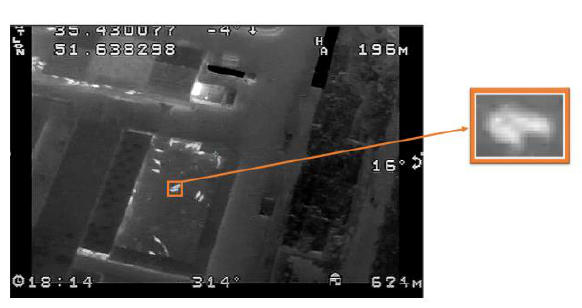
Figure 3: Example of target interesting for tracking Amongst various tracking algorithms, mean shift tracking algorithms have recently become popular due to their simplicity and robustness, (Comaniciu, 2003). The mean shift algorithm was originally invented by (Fukunaga, 1975) for data clustering. Recently this method successfully applied it to image segmentation and tracking. In these mean shift tracking algorithms, a colour histogram is used to describe the target region. The information theoretic similarity measures are commonly employed to measure the similarity between the template (or model) region and the current target region (Comaniciu, 2003) . Tracking is accomplished by iteratively finding the local minima of the distance measure functions using the mean shift algorithm. Fig. 4.